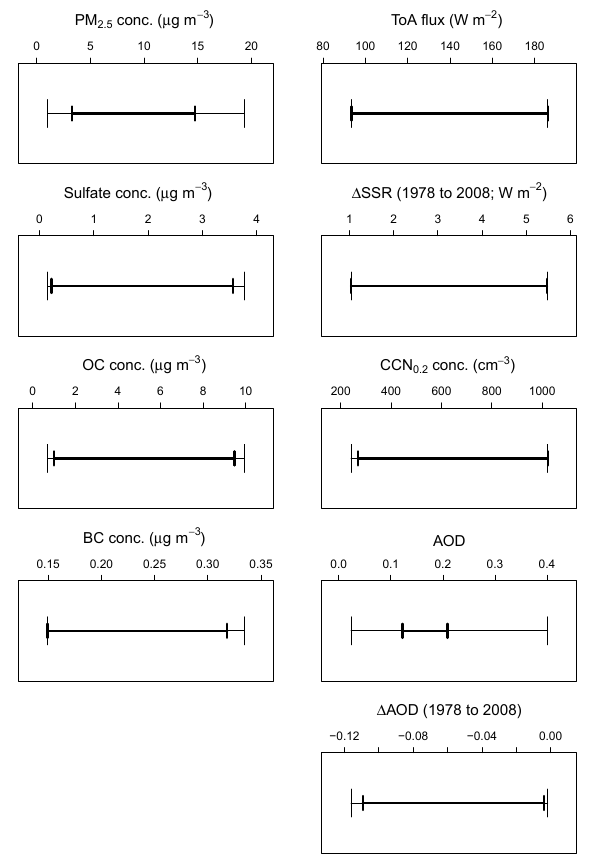
Figure 5. Effect of observational constraint of AOD on other aerosol properties in the model over Europe. The bars show the absolute range of the PDF before (thin line) and after (thick line) constraint. Results are for mean properties over Europe in